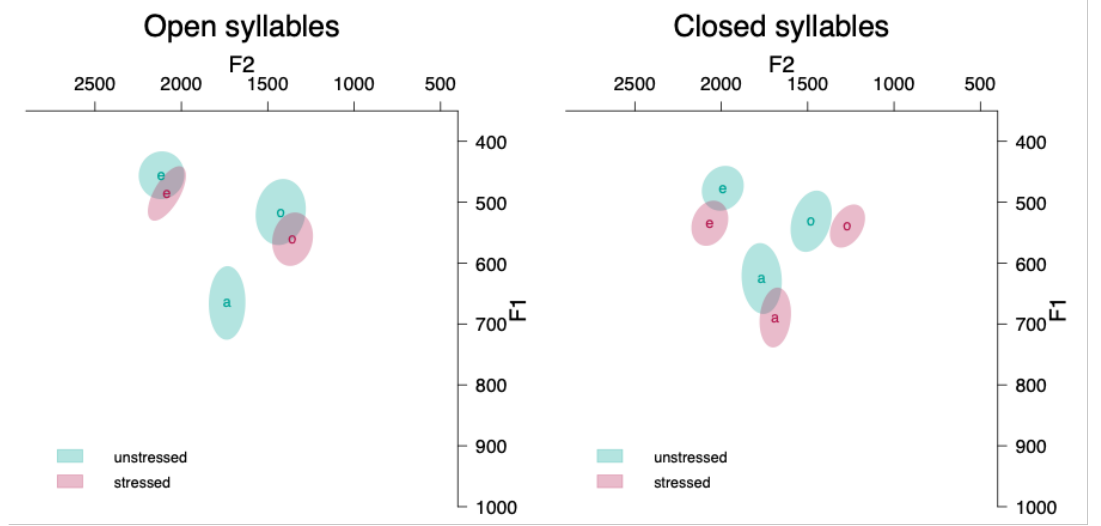
Figure 4. Vowel plots for realisations of /e, o, a/ in stressed and unstressed contexts in open syllables (left panel) and closed syllables (right